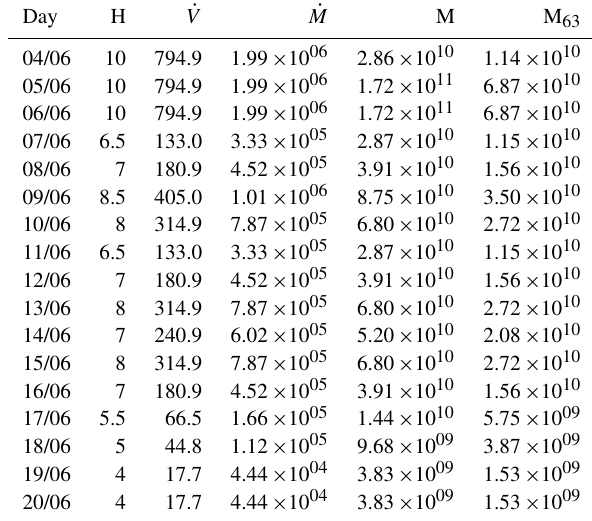
Table 7. Main characteristics of the volcanic emissions used for the hemispheric simulation. H: column height (km); ˙ V : volume flux (m 3 s − 1 ); ˙ M : Mass flux (kgs − 1 ); M: emitted mass (kg); M 63 : emit- ted mass for the fraction with diameter < 63µm.